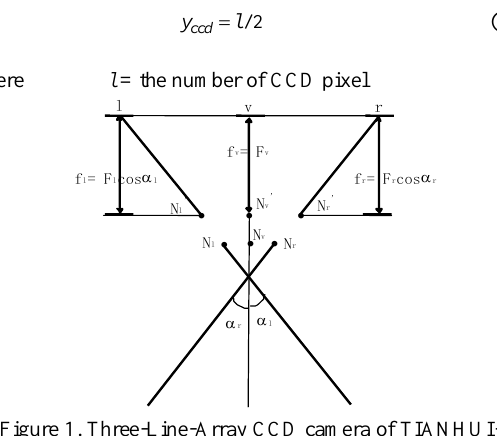
Figure 1. Three-Line-Array CCD camera of TIANHUI-1